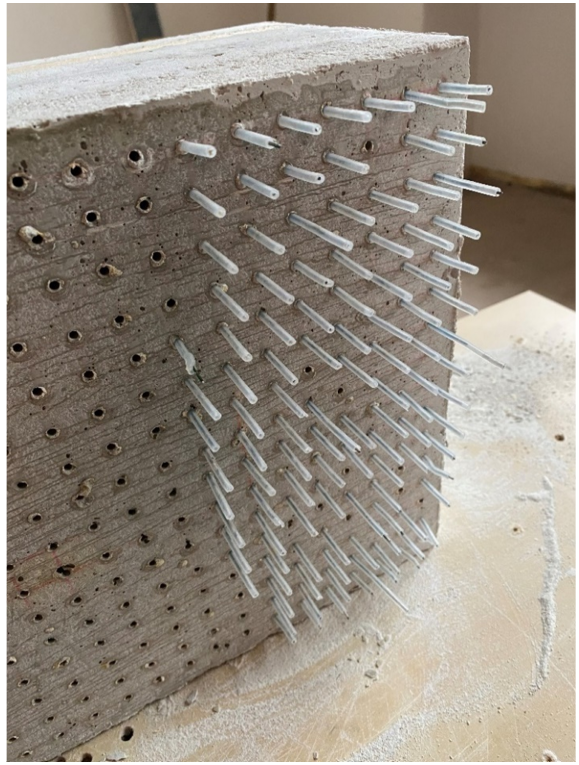
Figure 17. Sample with plastic tubes with wires.